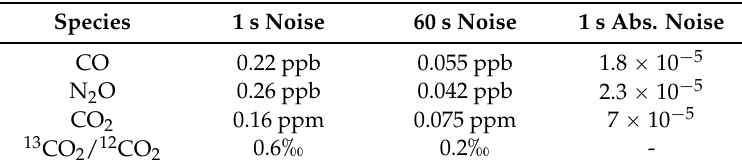
Table 2. Precision of concentration measurements with dual-wavelength